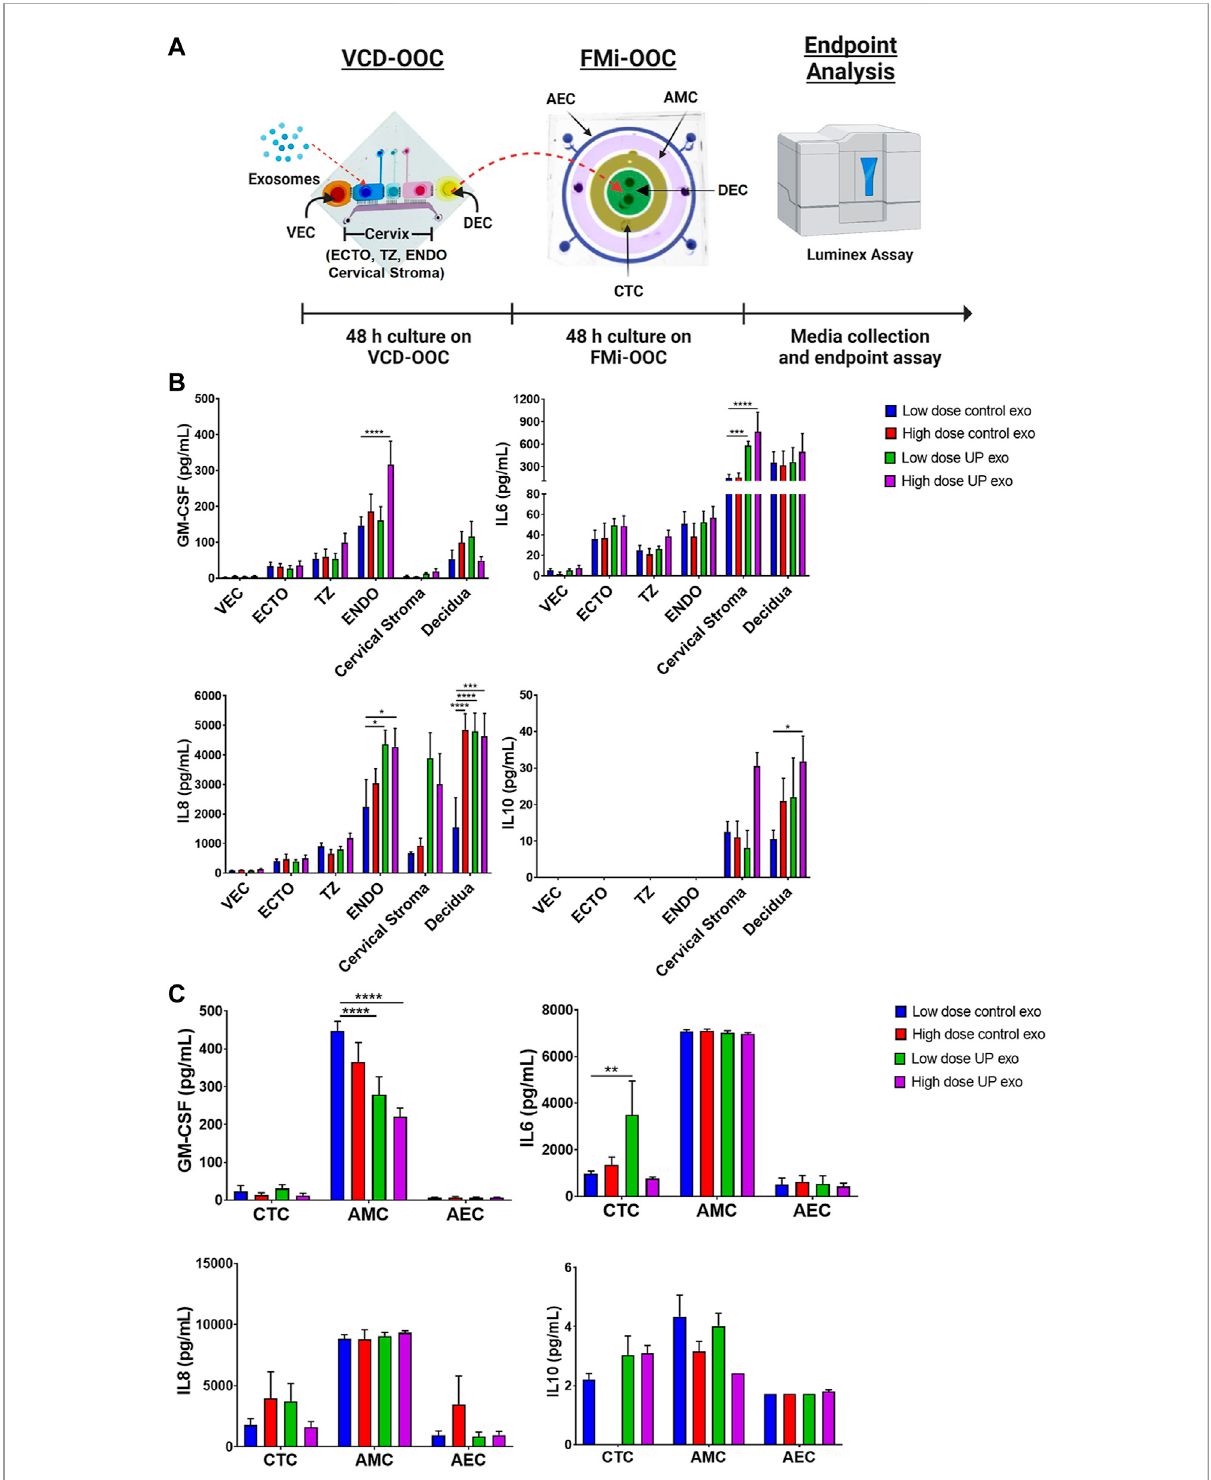
FIGURE4 In fl ammatory effects of exosomes from ECTO cells infected with U. parvum in the VDC-OOC and FMi-OOC. (A) We added low dose (2.2E6 particles) and high dose exosomes from uninfected and U. parvum -infected ECTO cells in the cell culture chamber for ectocervical epithelial cells. After 48 h, the cell culture media from the decidual cell chamber in the VCD-OOC was transferred to the decidual cell chamber of the FMi- OOC. Cell culture mediafrom each chamber intheVCD-OOCand FMi-OOCwerecollectedand subjected to Luminexassay to determine the